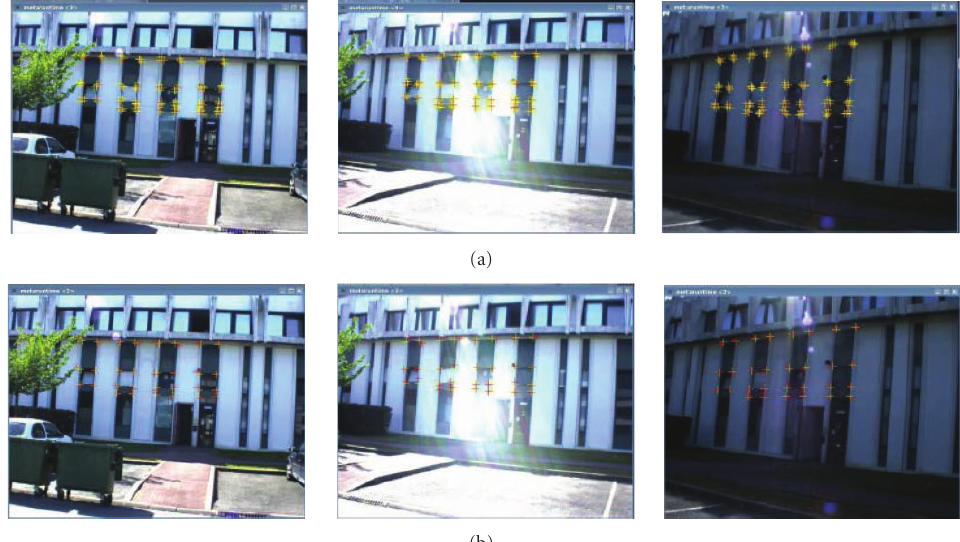
Figure 8: Performance of semiautomated approach.